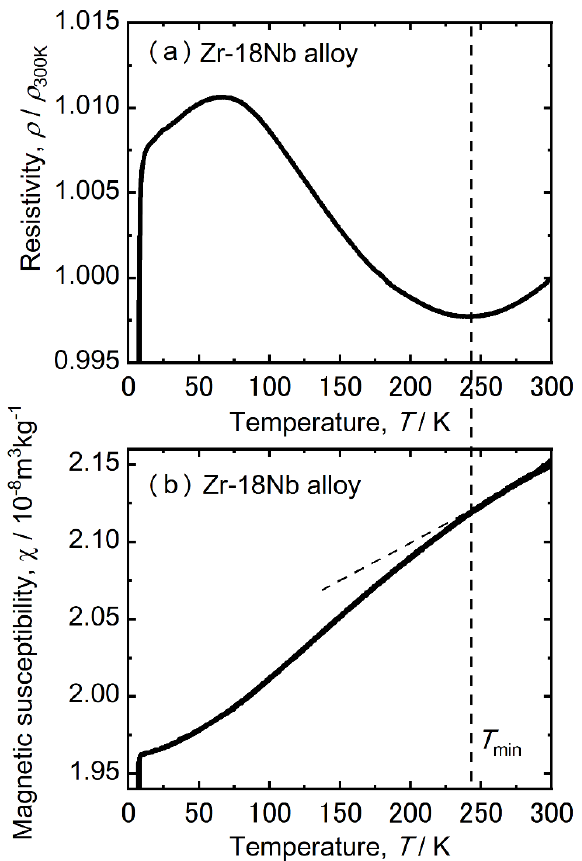
Figure 11. Electrical resistivity ( a ) and magnetic susceptibility ( b ) of the Zr-18 at.% Nb alloy.